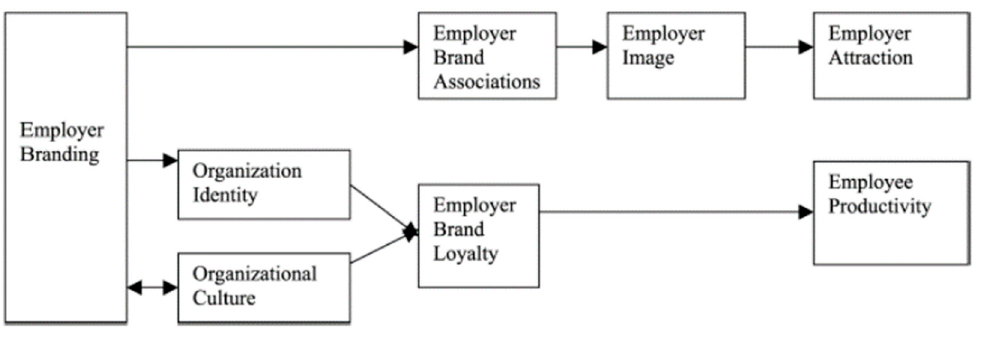
Figure 1. Employer branding as a three-stage procedure (Backhaus and Tikoo 2004) .